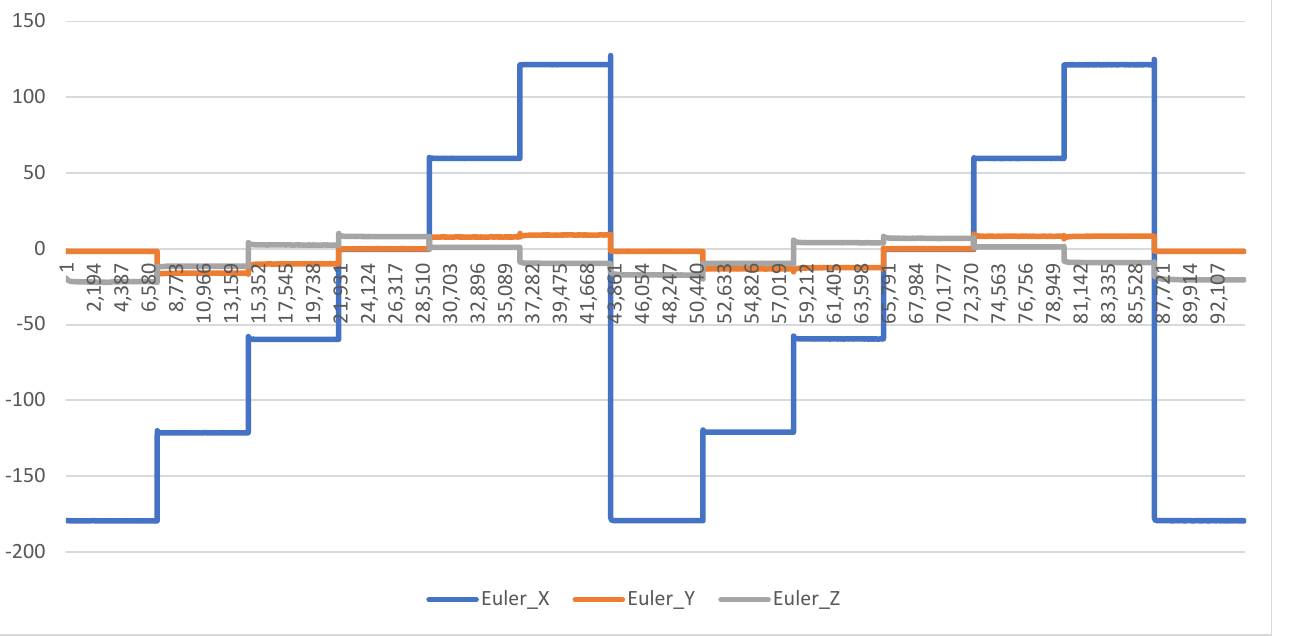
Figure 3. Orientation (in degrees) during Dynamic Drift Testing, demonstrating the expected 60‐degree changes in output orientation at 30 min intervals.